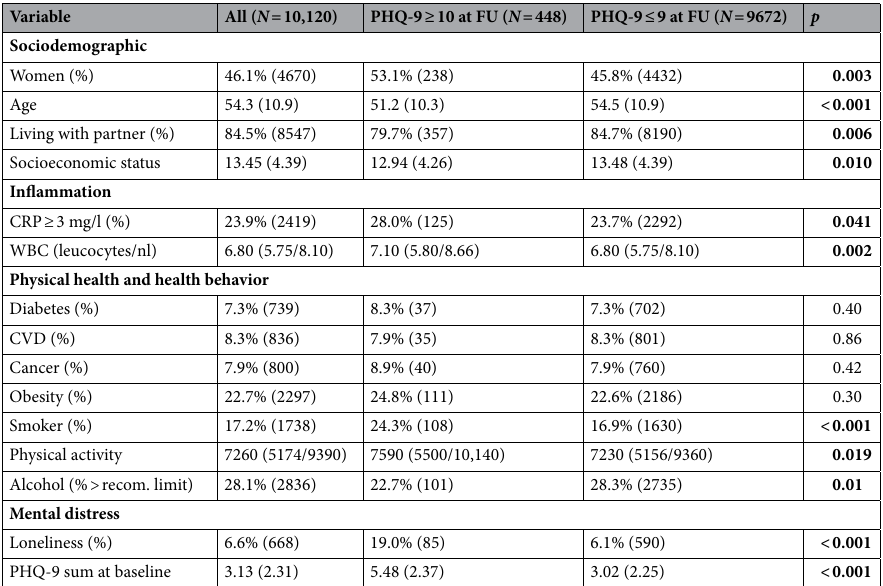
Table 1. Baseline participant characteristics (stratified by PHQ-9 ≥ 10 at follow-up). Bold values indicate statistically significant differences. Participant characteristics are shown as mean values and standard deviations, medians with interquartile ranges (if not fulfilling normal distribution) or as percentages and absolute numbers. CRP C-reactive protein, CVD cardiovascular disease, FU follow-up, PHQ‑9 patient health questionnaire-9, WBC white blood cell